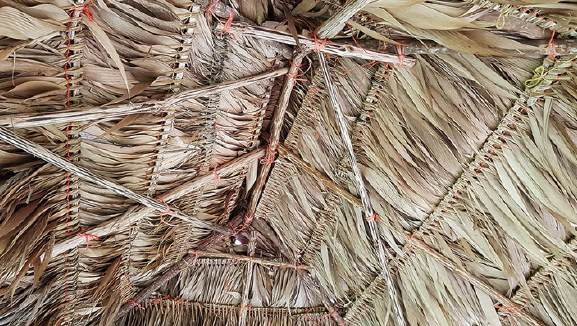
Figure 10. Oblique braces reinforcing the roof structure (Naso).